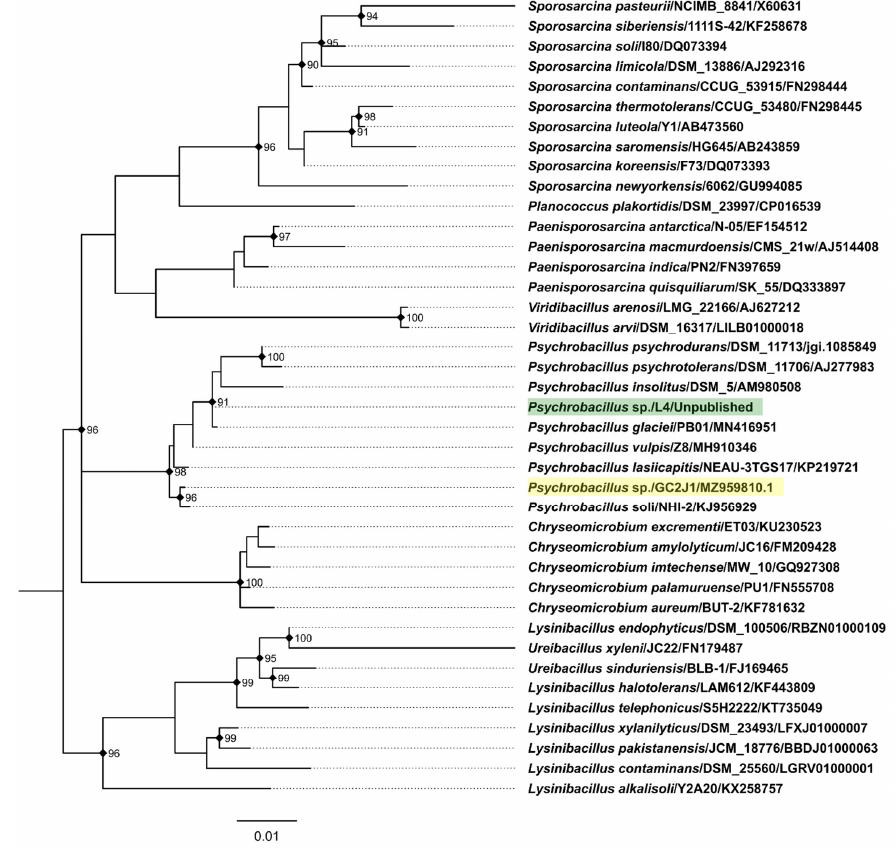
Figure 1. Maximum likelihood phylogeny of the partial 16S rRNA gene sequences of Psychrobacillus isolate L4 (host of phages Perkons and Spoks; tip label highlighted in green; sequence obtained us- ing common 27F and 1492R primers), Psychrobacillus isolate GC2J1 (host of phage PVJ1; tip label highlighted in yellow) and validly named closely related bacterial isolates found in the EzBioCloud